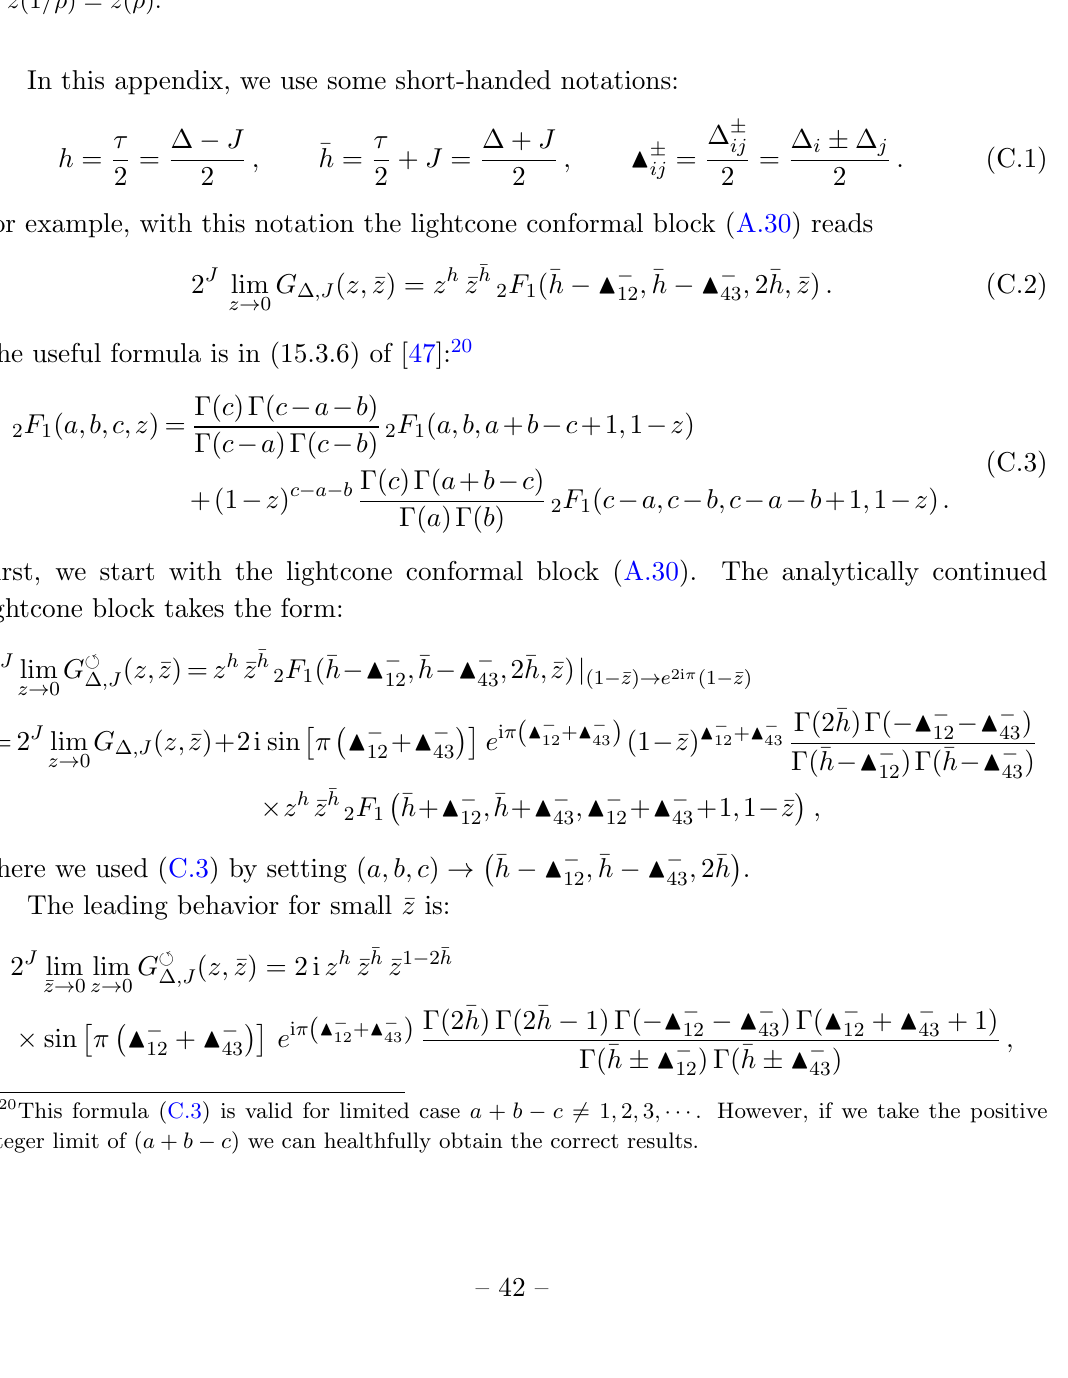
Figure 12 . These two (cid:12)gures illustrate the paths of ( z; (cid:22) z ) and ( (cid:26); (cid:22) (cid:26) ) in the second ordering of (2.42) during the analytic continuation to (cid:22) (cid:26) > 1 regime. In this procedure, both (cid:26) and (cid:22) (cid:26) remain in the unit sphere. Thus neither z nor (cid:22) z crosses the branch cut on positive real half line [1 ; 1 ) anymore. The (cid:12)nal value of (cid:22) (cid:26) is the inverse of that in (cid:12)gure 5, whereas the (cid:12)nal con(cid:12)gurations of z , (cid:22) z and (cid:26) are the same as those in (cid:12)gure 5. That is because of the two-to-one correspondence between (cid:22) (cid:26) and (cid:22) z : (cid:22) z (1 = (cid:22) (cid:26) ) = (cid:22) z ((cid:22) (cid:26)